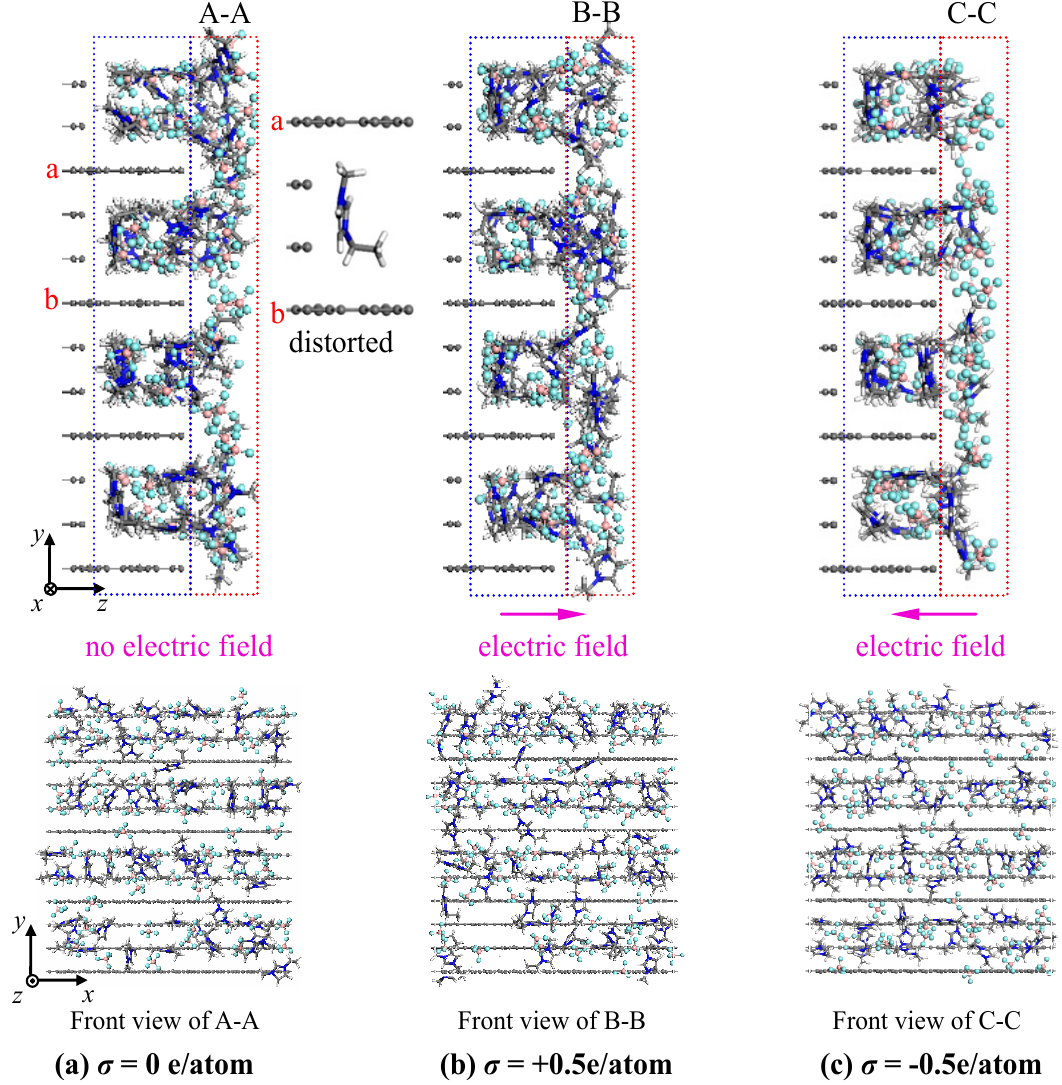
Figure 3. Snapshots of ions in the layer close to the rough electrode surface with different charges: ( a ) σ = 0 e/atom, ( b ) σ = +0.5 e/atom, ( c ) σ = − 0.5 e/atom.